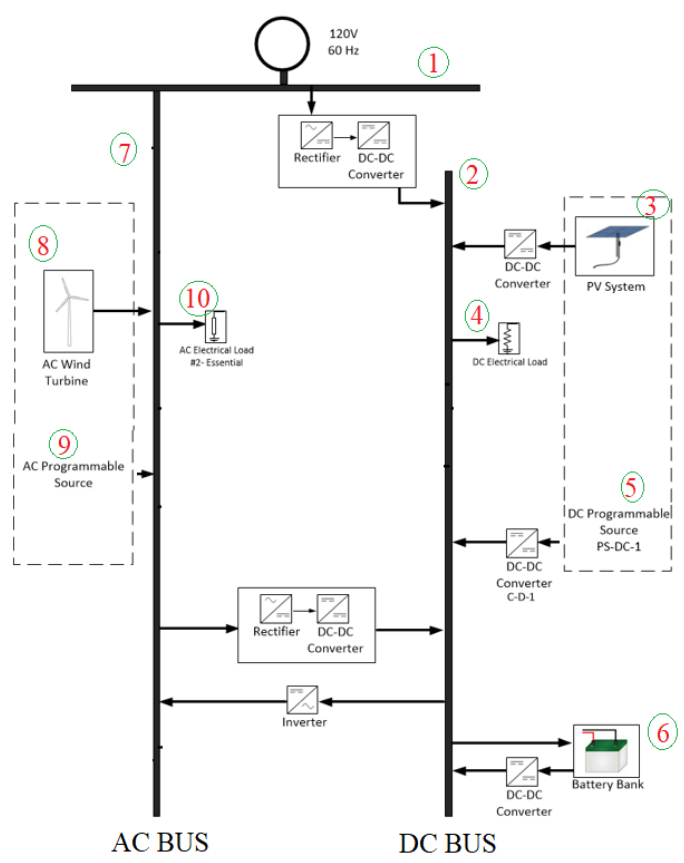
Figure 2. The experimental setup of the proposed scheme of the